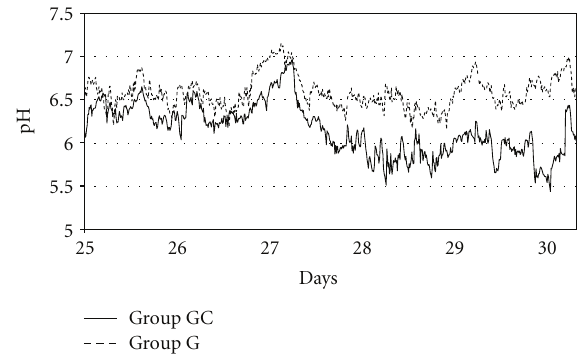
Figure 1: Phase patterns of mean reticuloruminal pH during the first 26 days of examination (feed changeover period) from barn feeding (phase 1), 10h/d-pasture (phase 2), and 20 h/d (phases 3– 7). Vertical bars indicate SE of phase means. 1 Least squares means, 2 SE of least squares means.